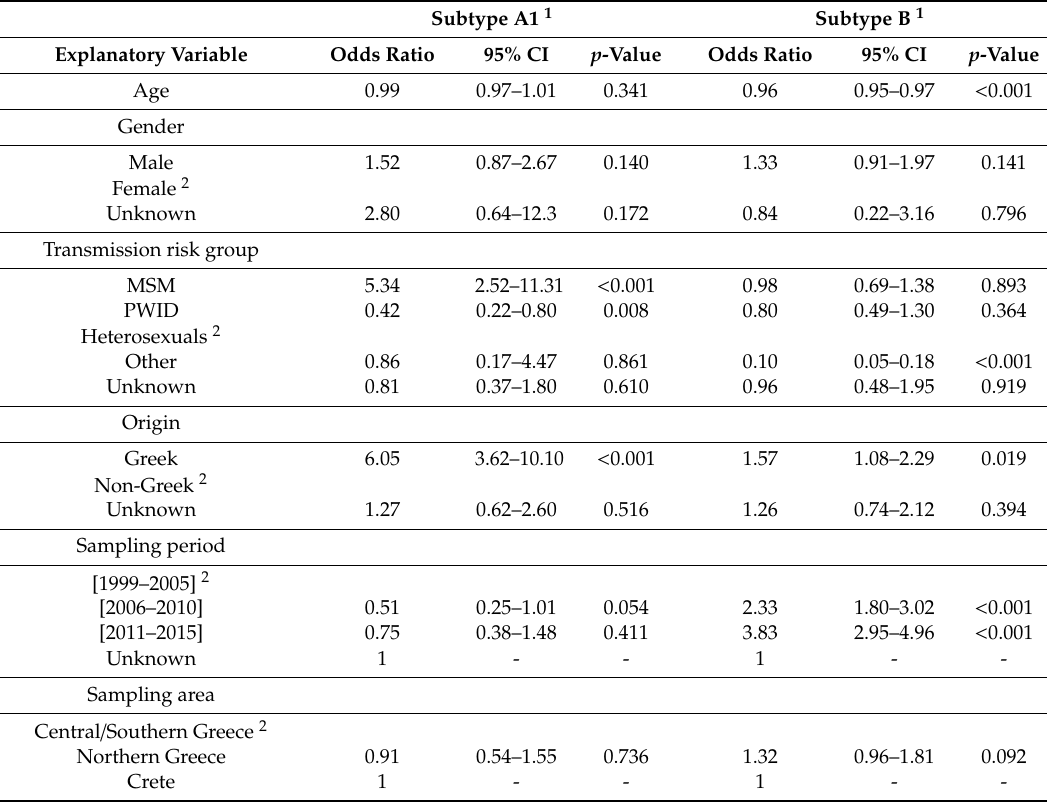
Table 3. Multivariable logistic regression estimates using the presence in molecular transmission clusters (MTCs) as the binary outcome